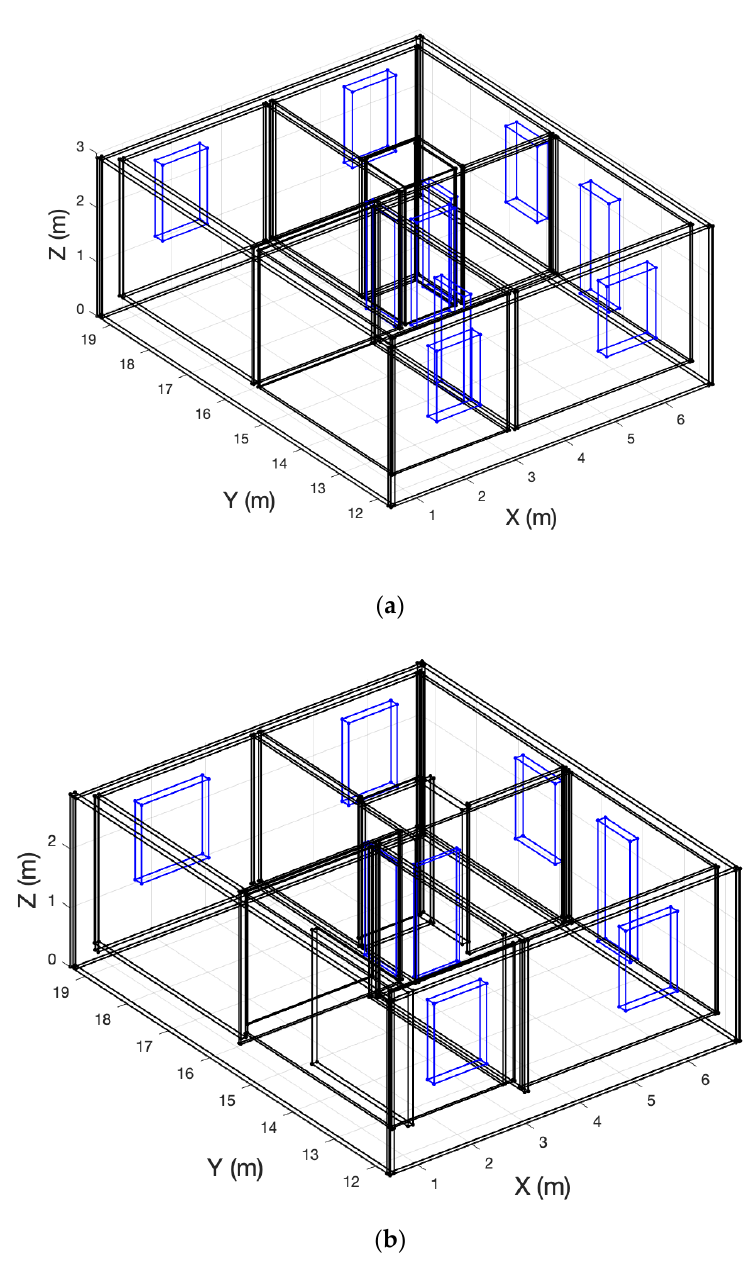
Figure 15. Signal House: ( a ) Truth model; ( b ) Calculated model. Walls in black, windows and doors in blue.